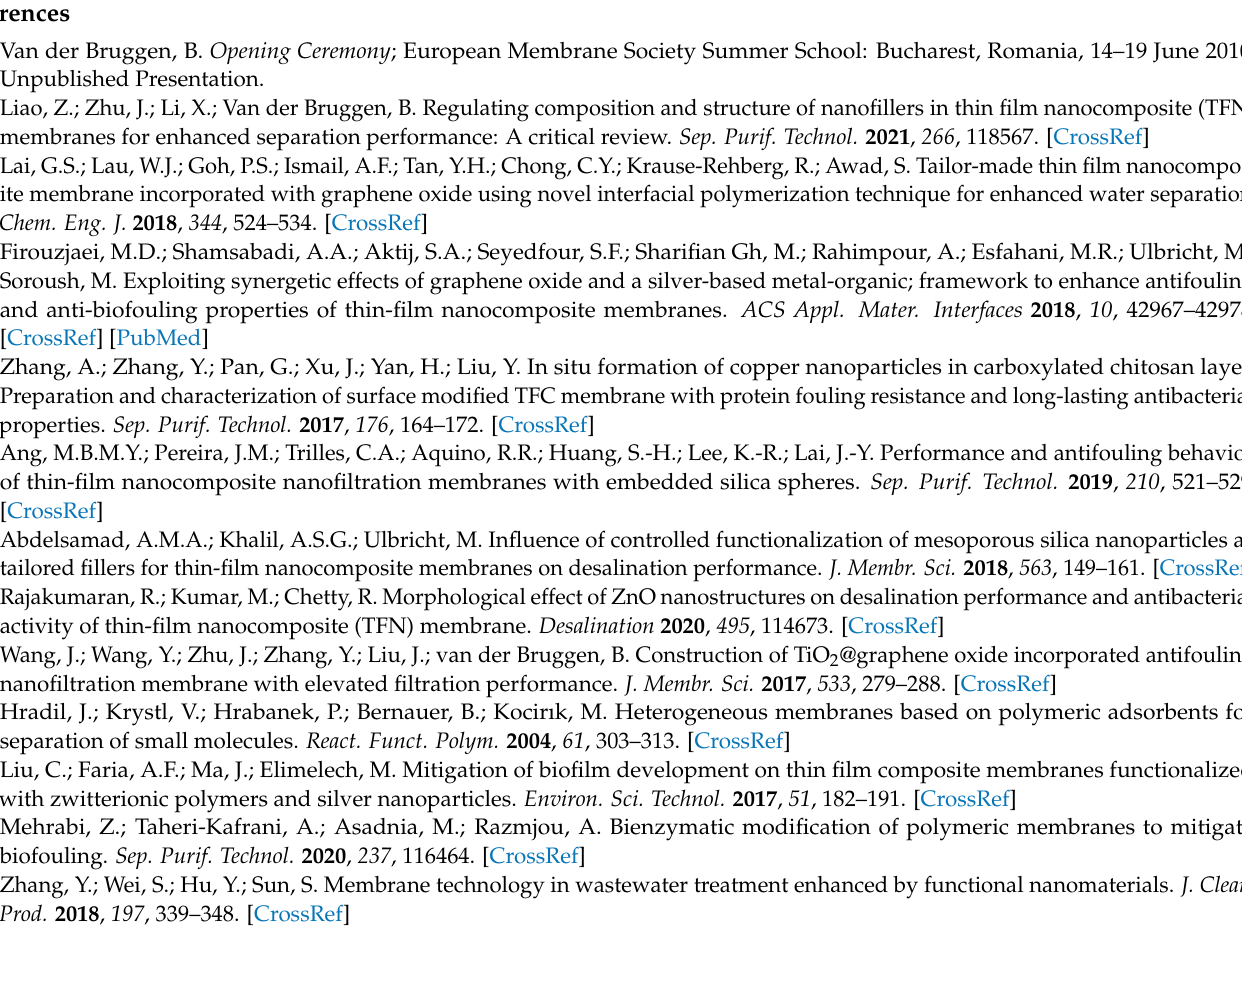
Figure S2: Details of the essential elements of the pertraction installation; Figure S3: EDAX diagrams; Figure S4: XRD diagram for the obtained nanoparticles; Figure S5: General thermal diagrams; Figure S6. SEM images of NPP nanoparticles; Figure S7: The pertraction mechanism through supported liquid membranes; Table S1: Silver sources